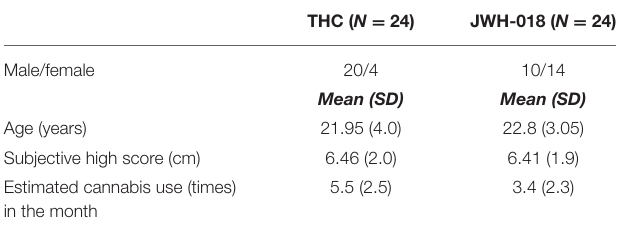
TABLE 1 | Demographics of the participants in the THC and JWH-018